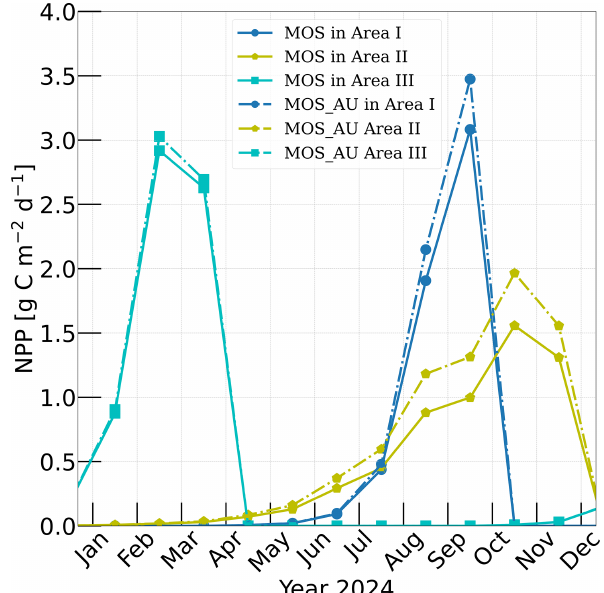
Figure 2. Annual vertically integrated macroalgae biomass of MOS ( a ) and MOS-AU ( b ) in year 2024. Solid red lines outline the MOS- occupied area at year 2024 in both, while dashed red lines outline the initial MOS seeding area at year 2020 in ( a ). The simulated MOS area generally covers the NO 3 -rich ocean surface ( a ) and can be expanded with nutrients supplemented by AU ( b ), making it larger than the estimated adequate area for macroalgae in previous studies Lehahn et al., 2016; Froehlich et al., 2019). Results for Ar- eas I (blue circle), II (yellowish pentagon) and III (cyan rectangle) are discussed in the text and displayed in Fig. 3. Braces indicate the belts of N, M and S with various seeding strategies of macroalgae (Table 2), which are designed to avoid winter periods.